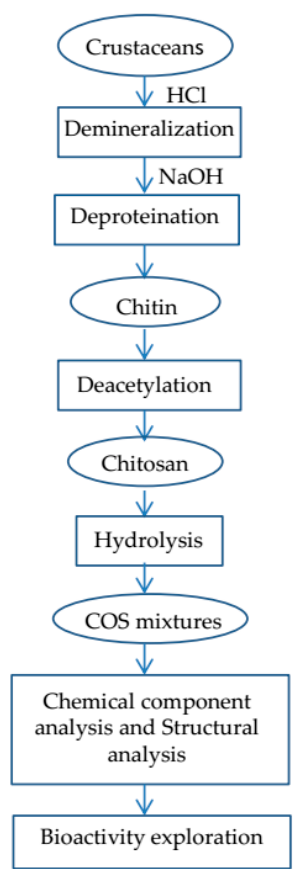
Table 1. The advantages and disadvantages of various preparation methods of COS.